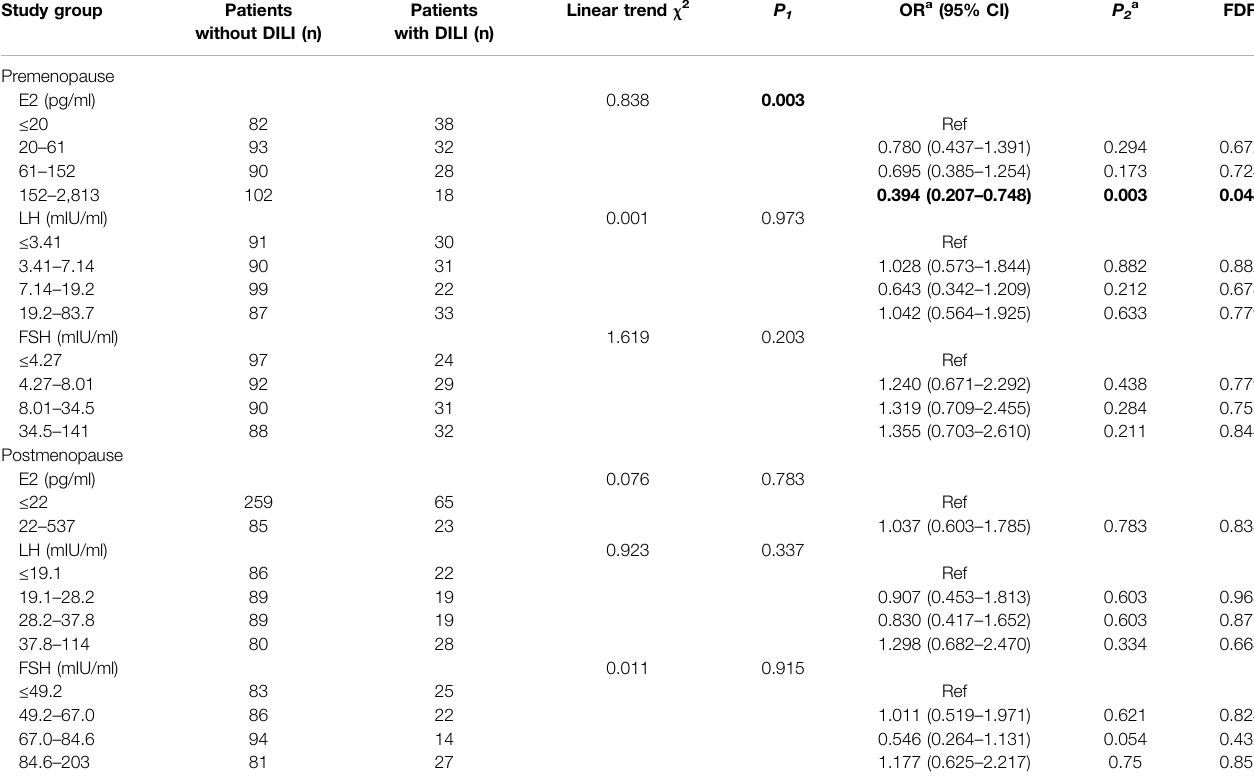
TABLE 4 | Analysis of estrogen levels associated with DILI in premenopausal and postmenopausal patients. Study